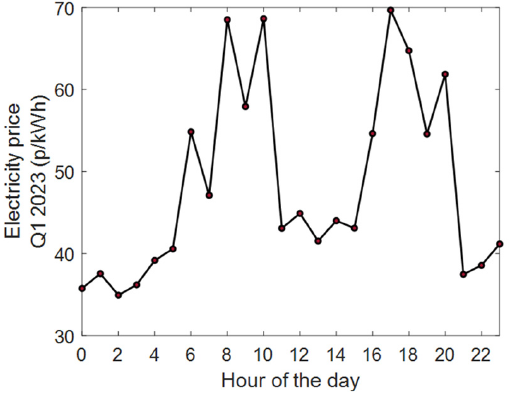
Figure 6. Simulated electricity prices for one day of the year (from 00:00 h to 23:00 h) for the WMD.